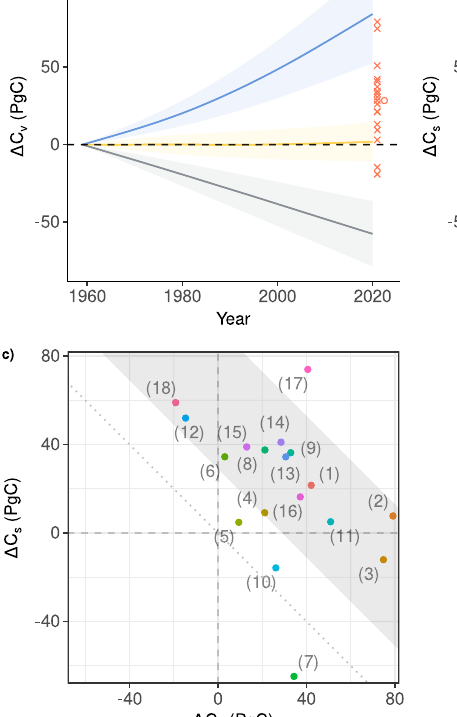
output is fi rst smoothed using a fourth-order spline. The cumulative net (sum of three drivers) change in global carbon stocks by 2020 is shown (red crosses show each model and red circle shows the model mean). c Shows the change in vege- tation and soil stocks for each of the 18 models and the grey region is the Global Carbon Budget net land sink constraint (see